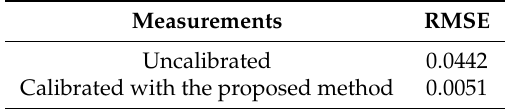
Table 4. RMSE of the measurements before and after executing the proposed calibration method.